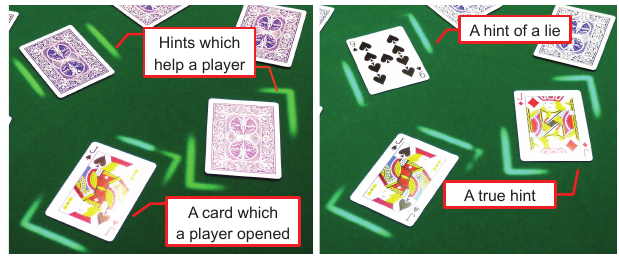
Figure 11. A hint is projected with light (left) and the hint is shown to be true when the player turns over the card